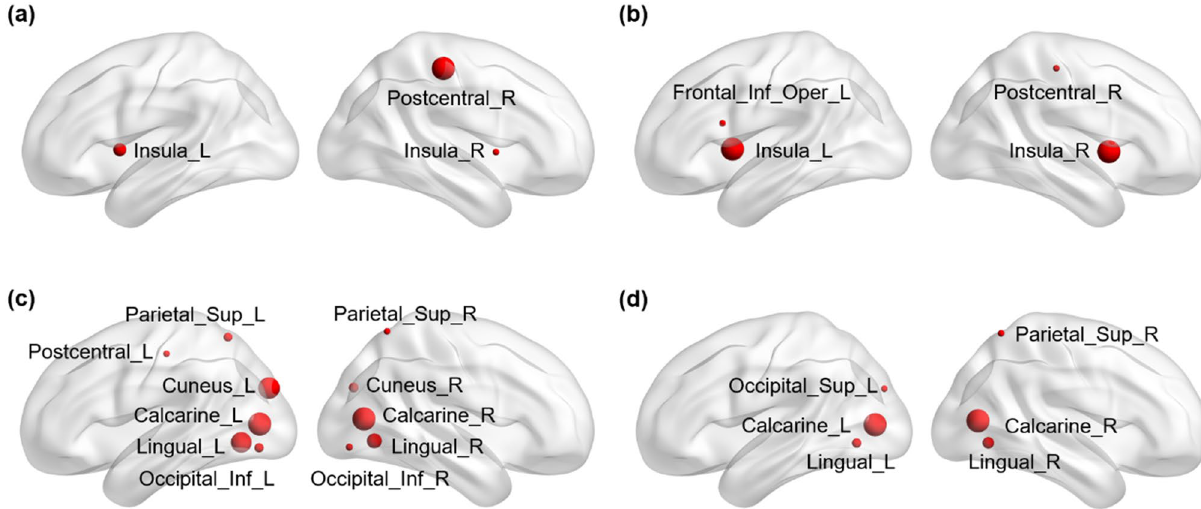
Figure 3. Alpha diversity of gut microbiota in the SZ patients showed strong positive correlations with GMV and ReHo. ( a ) Brain regions showing significant correlations between the residuals of the GMV index and the observed species alpha diversity. ( b ) Brain regions showing significant correlations between the residuals of the GMV index and the Faith_PD of alpha diversity. ( c ) Brain regions showing significant correlations between the residuals of the ReHo index and the evenness of alpha diversity. ( d ) Brain regions showing significant correlations between the residuals of the ReHo index and the Shannon alpha diversity. The size of the node indicates the relative size of the r value of the significant correlation; the red color of the node indicates a positive correlation between the residuals of the GMV as well as the ReHo indexes and the residuals of the alpha diversity. Sup: superior; Inf: inferior; L: left hemisphere; R: right hemisphere. Figure was generated by a brain network visualization tools of “BrainNet Viewer” (Version 1.7, https:// www. nitrc. org/ proje cts/ bnv/), based on MATLAB (Version